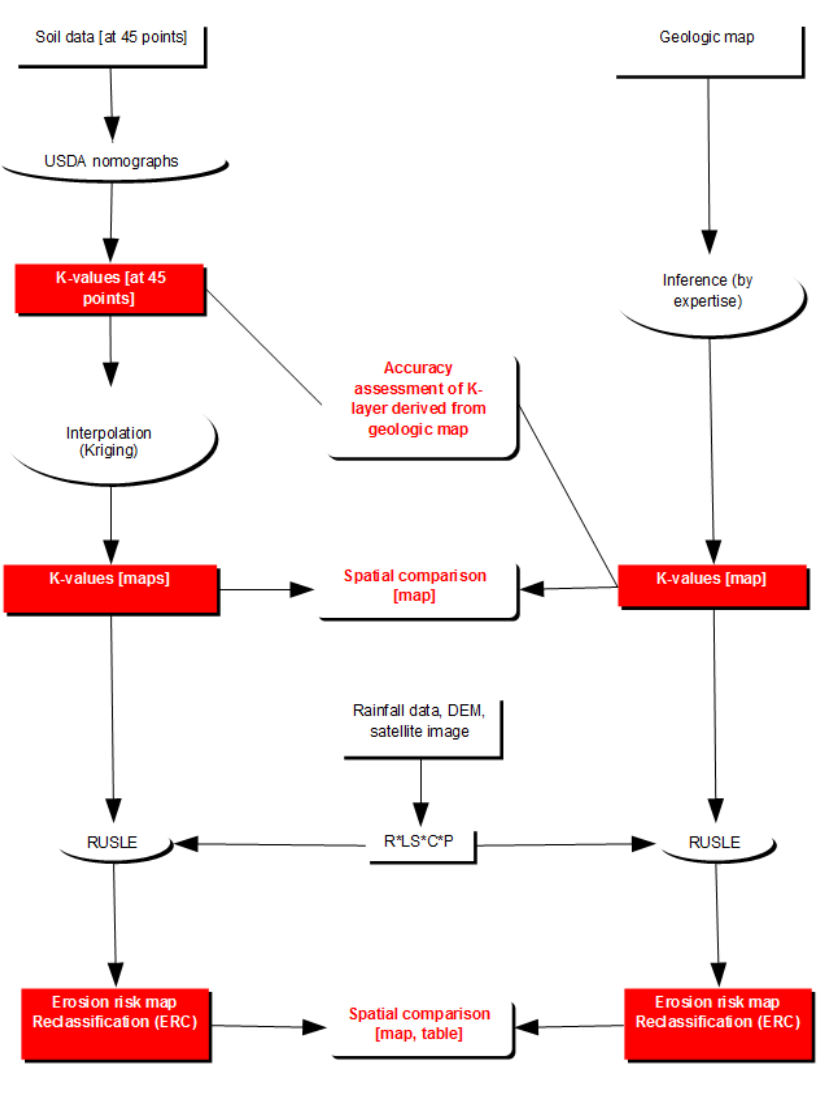
Figure 3. Workflow of the